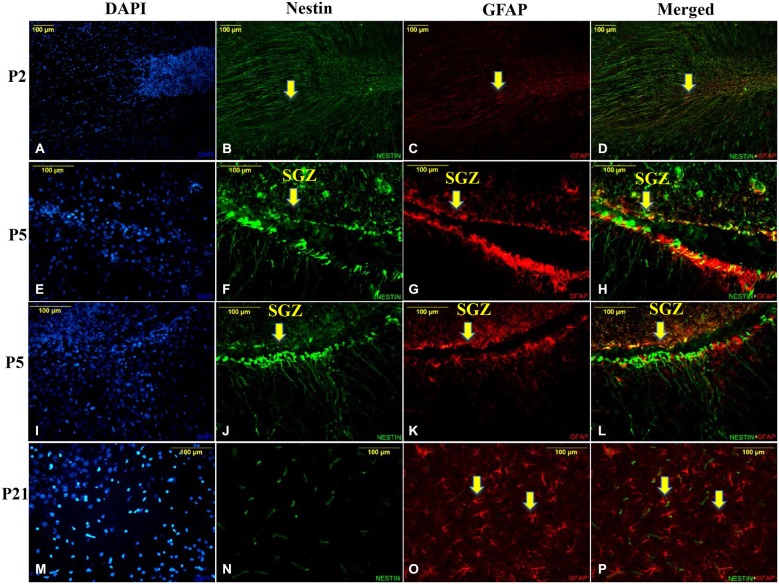
Stem astrocytes forming the glial tubes in neocortical SVZ and at SGZ co-express Nestin and GFAP. Immunofluorescence staining for DAPI (blue; A,E,I,M), Nestin (green; B,F,J,N) and GFAP (red; C,G,K,O). Merged images are shown in (D), (H), (L) and (P). Stem astrocytes forming the glial tubes in the neocortical SVZ (arrows; D) and those lining the SGZ and SVZ co-express Nestin and GFAP (H,L). Mature astrocytes at P21 express only GFAP and no Nestin staining was detected (P).